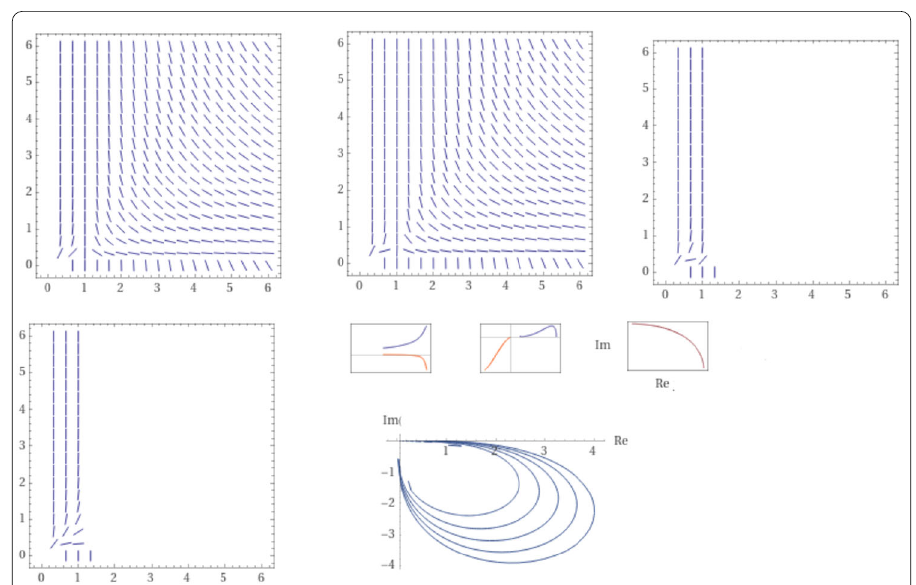
Figure 1 The slope fields of solutions of (3.1) in Example 3.6